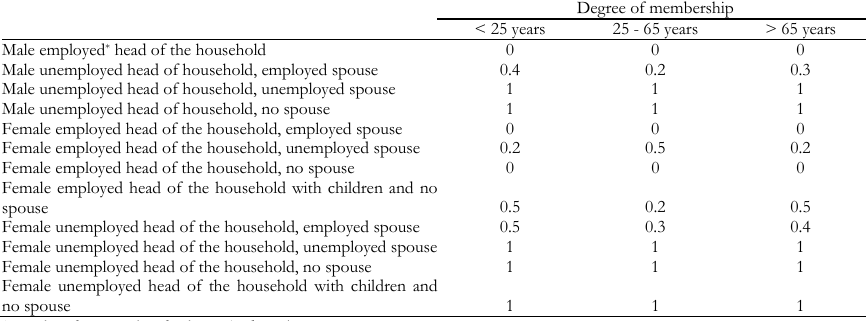
Educational achievement of the household head and his/her father Father